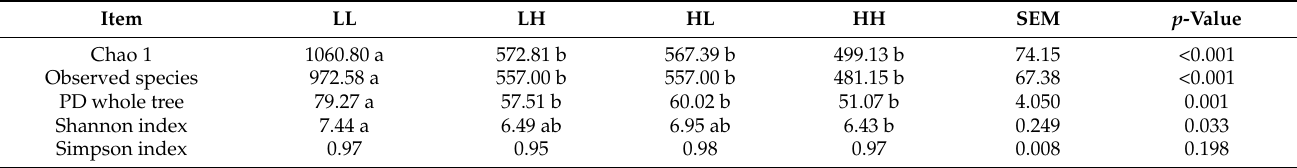
Table 3. Effect of the energy provision strategy on the rumen bacterial alpha-diversity metrics of Hu